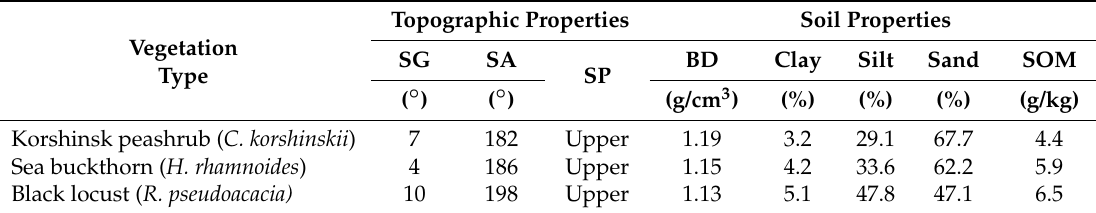
Table 2. Topographic and soil properties for each type of